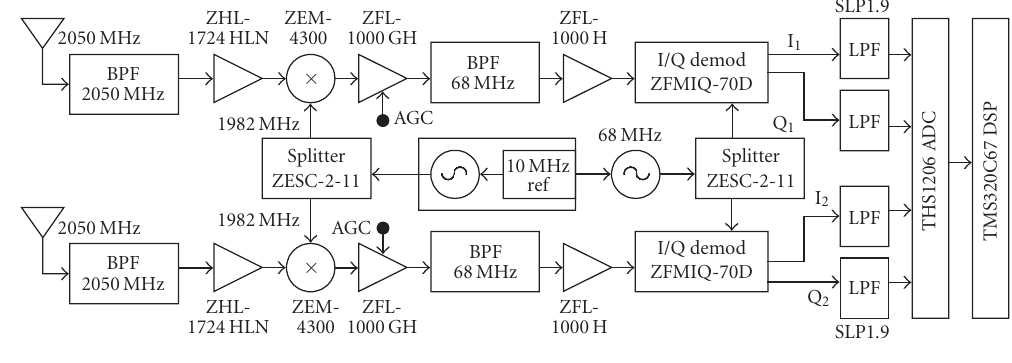
Figure 5: Receiver